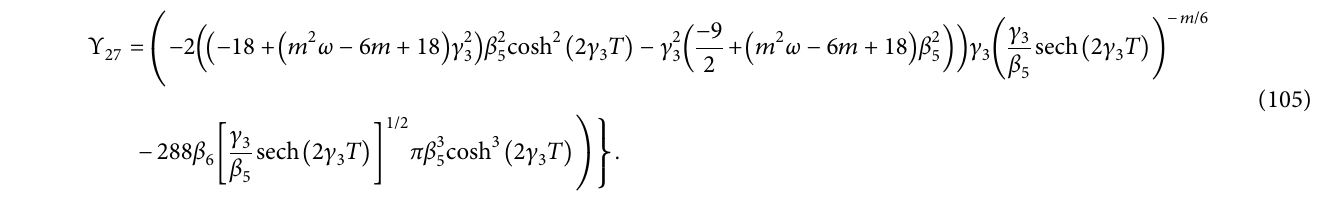
) versus redshift ( z ) for s